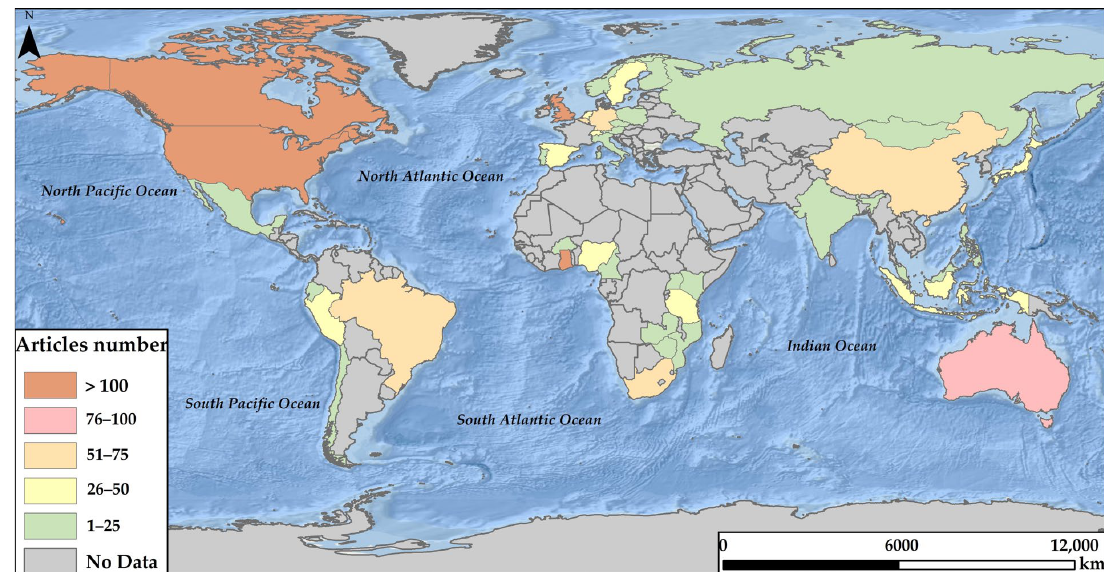
Figure 4. Contribution of studies related to ASM by country.